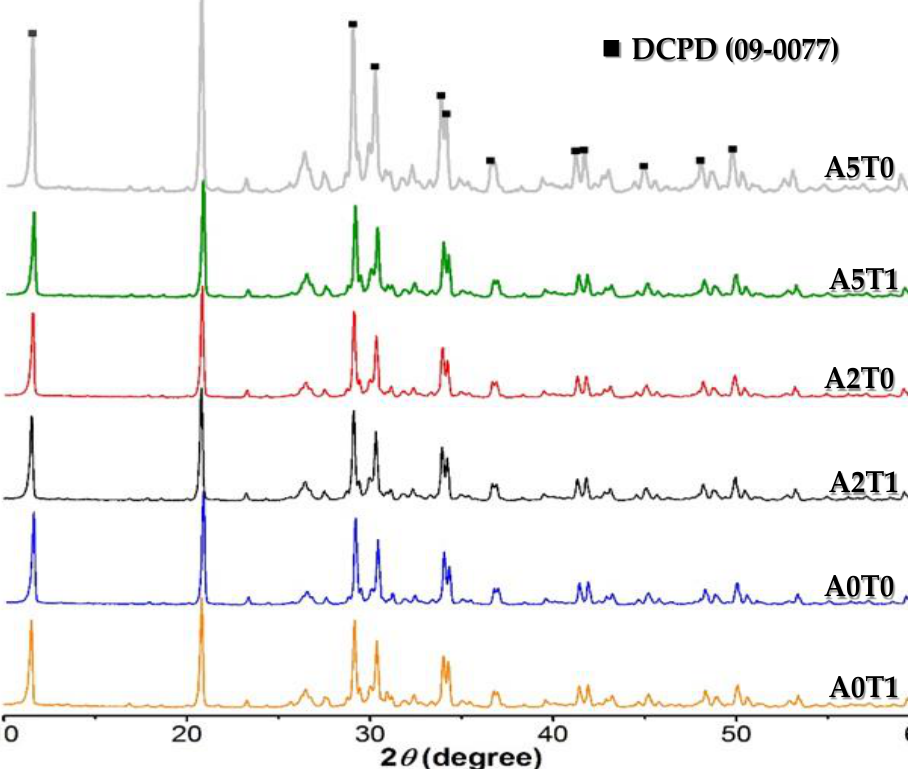
Figure 1. XRD pattern of samples. All peaks correspond to DCPD according to the ICDD PDF 9-0077 X-ray diffraction pattern. The six-maximum intensity DCPD peaks could be observed between 12°and 35° at 2 θ .